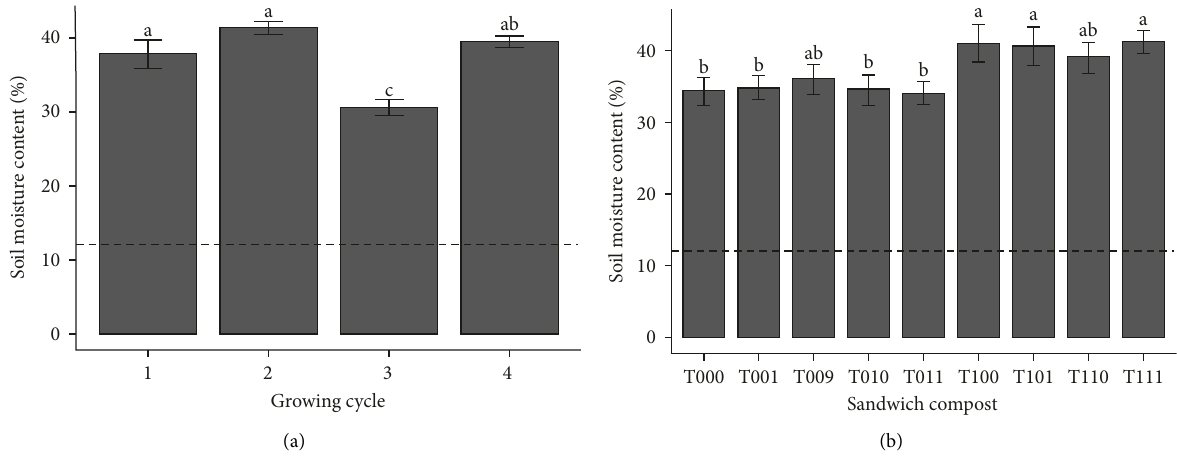
Figure 3: (a) Effect of the growing cycle on soil moisture content (%). (b) Sandwich compost amendments on soil moisture content (%). Mean ± standard error with different letters is significantly different at P < 0 . 05 when using DMRT. The dotted line is referred to as the original soil moisture content (12%).